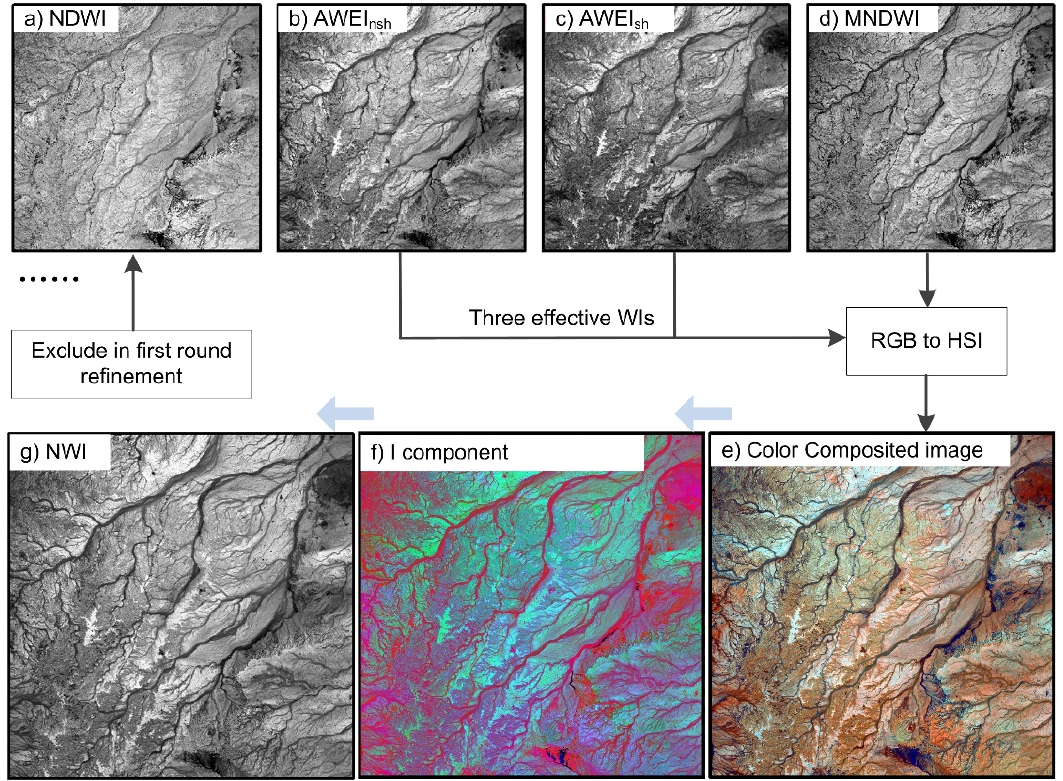
Figure 4. Illustration of the conceptual basis of the proposed methodology. ( a ) NDWI; ( b ) AWEI nsh ; ( c ) AWEI sh ; ( d ) MNDWI; ( e ) Original color composited image; ( f ) I component; ( g ) new WI.